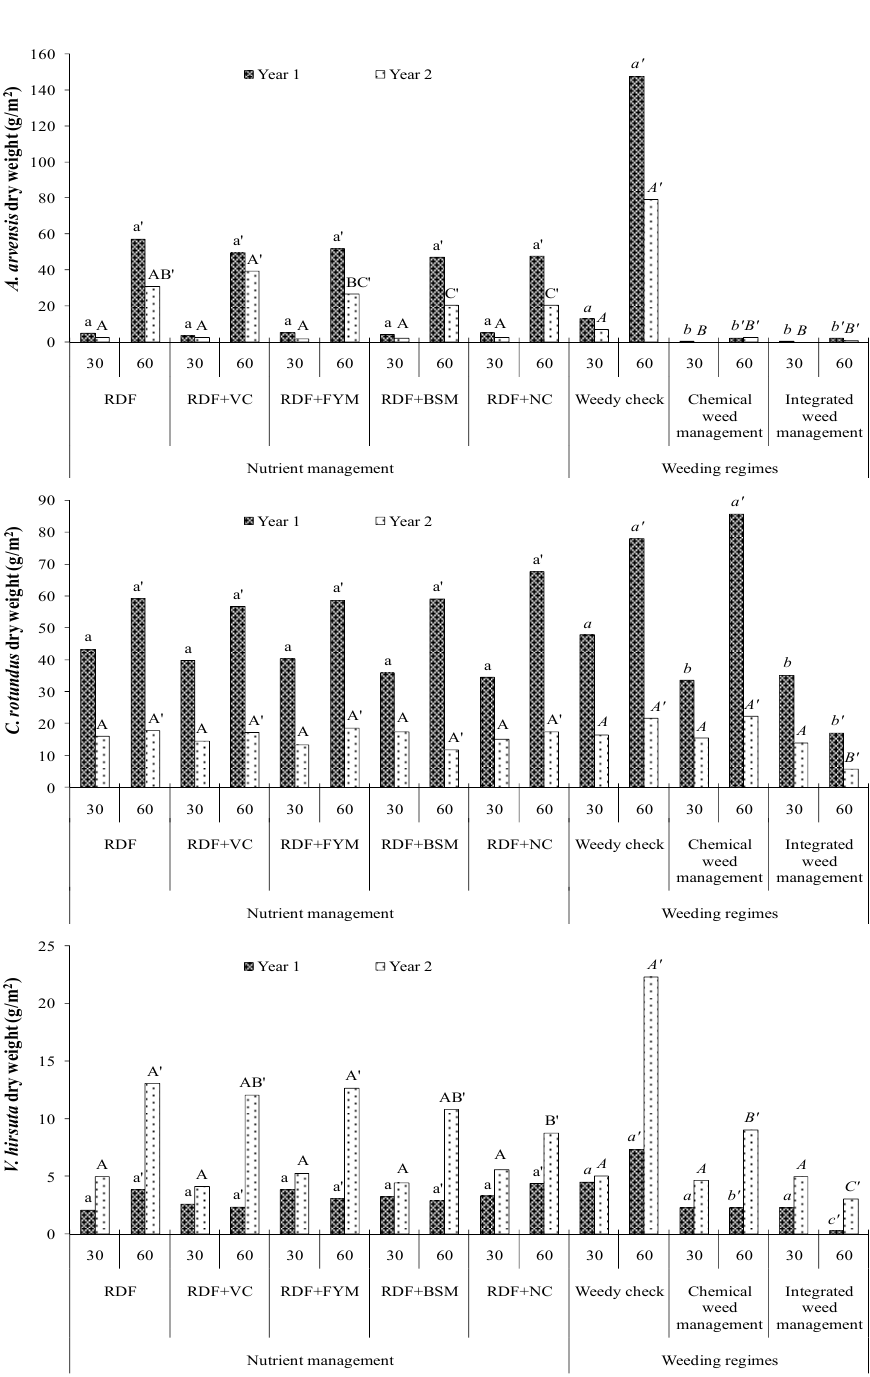
Figure 2. Effect of different nutrient managements and weeding regimes on weed dry weight (g/m 2 ) at both 30 and 60 DAS in hybrid maize. RDF: 100% recommended dose (RD) of NPK through fertilizer, RDF + VC: 25% RDN through VC, RDF + FYM: 25% RDN through FYM, RDF + BSM: 25% RDN through BSM, RDF + NC: 25% RDN through NC, Weedy check: Un-weeded control, Chemical weed management: Atrazine 1000 g ha -1 at 2 DAS, Integrated weed management: Atrazine 1000 g/ha at 2 DAS followed by mechanical weeding at 30 DAS. Effects of nutrient source recorded at 30 DAS in year 1 indicated with the lower case of letter (a or b) and indicated with upper case of letter (A or B) in year 2; however data recorded at 60 DAS indicate as lower case with ( ′ ) (a’ or b’) in year 1 and upper case with ( ′ ) (A’, B’ or AB’) in year 2; while effect of weed management in year 1 as italic lower case, in year 2, italic upper case at 30 DAS, as italic lower case with ( ′ ) (a’ or b’) in year 1 and italic upper case with ( ′ ) (A’, B’ or AB’) in year 2 at 60 DAS.